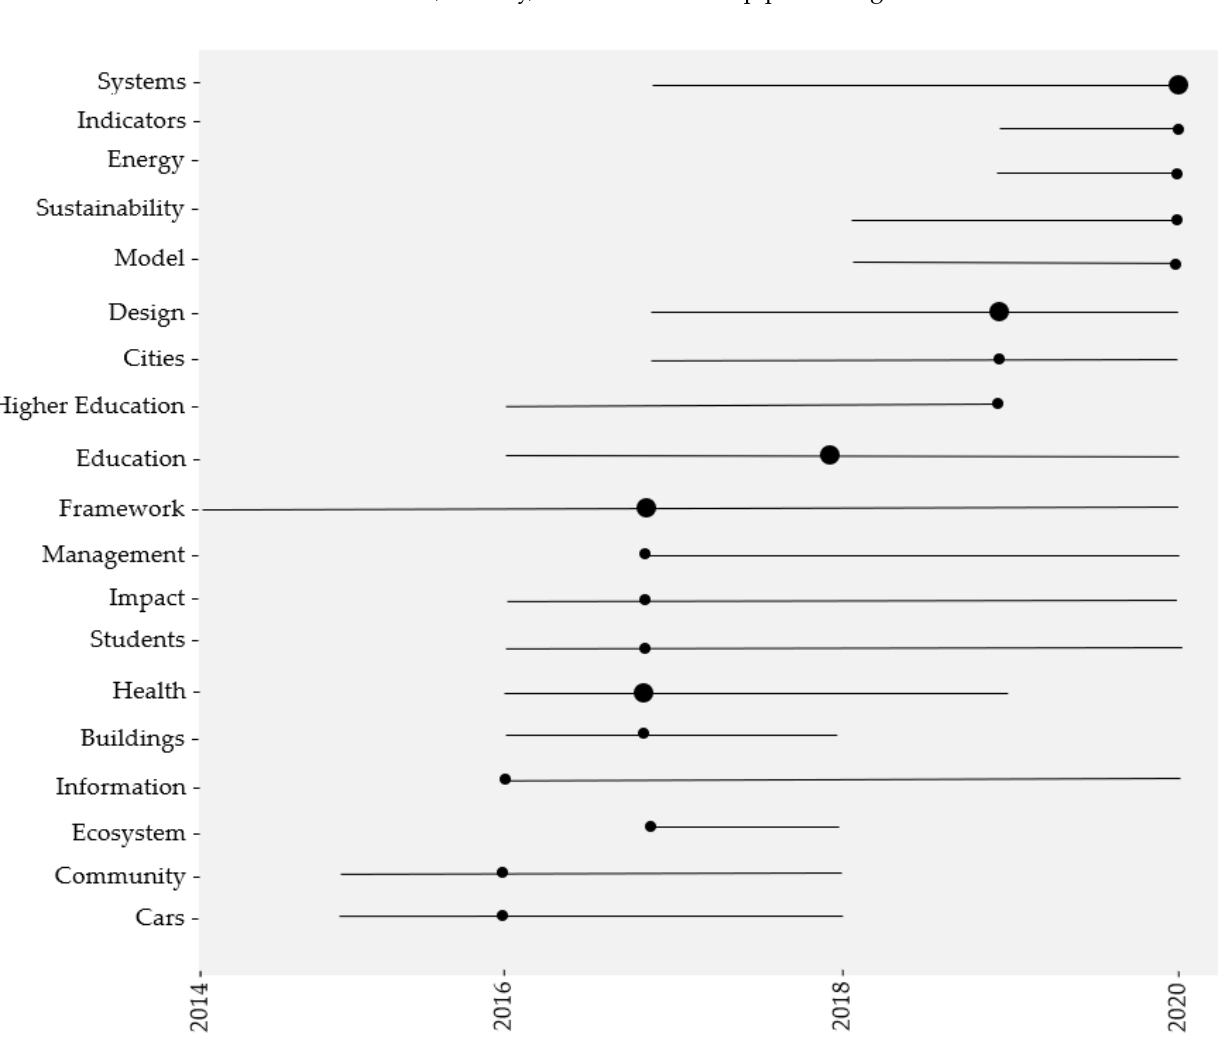
Figure 5. Trending keyword terms related to sustainable education in the construction industry.